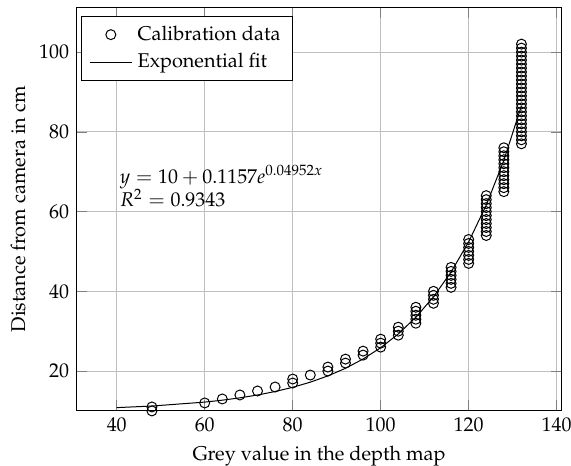
Figure 8. Correspondence between the depth map grey values and object distance determined empirically during the calibration of the Lytro LF light-field